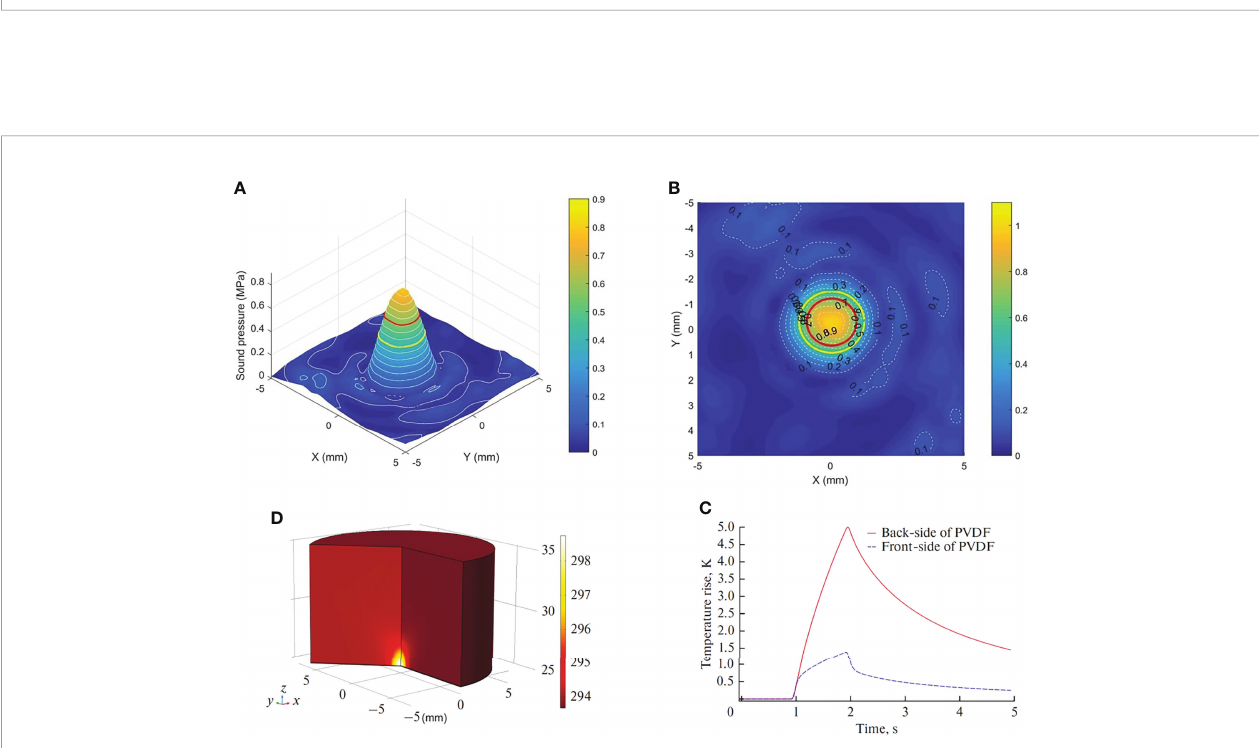
FIGURE 2 | Characterization of the in situ ultrasound fi eld and temperature change. (A) 3-D plot of the peak negative pressure on the hydrophone scan plane. (B) 2-D plot of the peak negative pressure. Red circle: − 3 dB focal region. Yellow circle: − 6 dB focal region. (C) Temperature rise in the sensor. (D) Temperature change at the front side and back side of